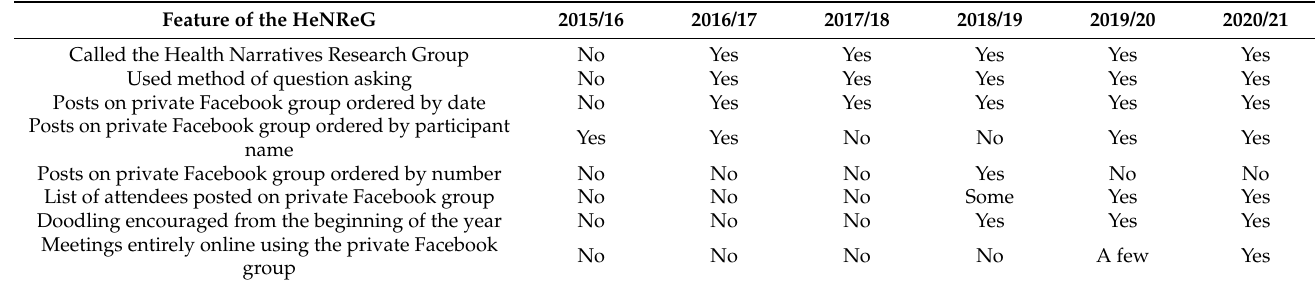
Table 4. Features of the HeNReG over its Six Years of